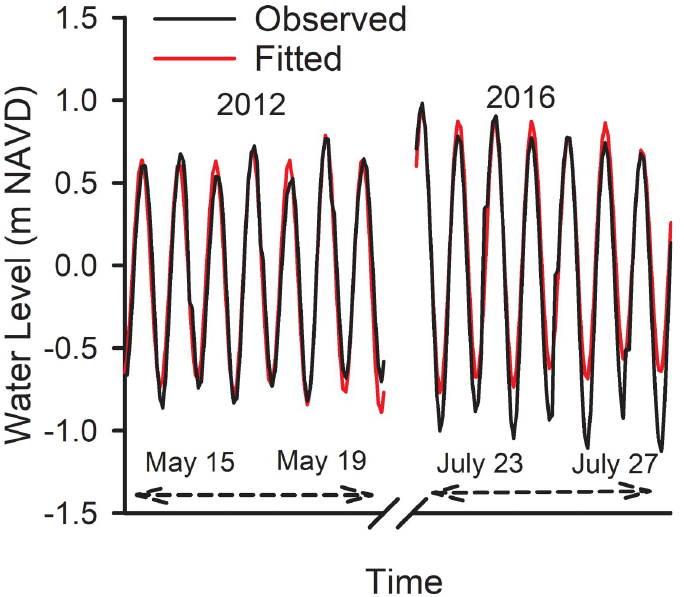
Fig 5. Hourly time series of water level. Details from the hourly time series of water levels. Predictions are from Eq 6. Observed data from NOAA station 8665530.